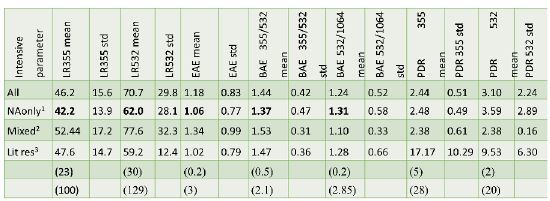
Table 1. Mean intensive parameters for long range transport from N America.